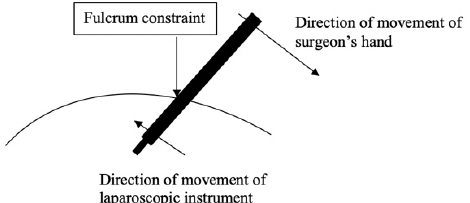
Figure 1. The fulcrum effect and its application to laparoscopic surgery. The surgical tool moves in the opposite direction of the surgeon’s hand due to the pivot point (fulcrum).